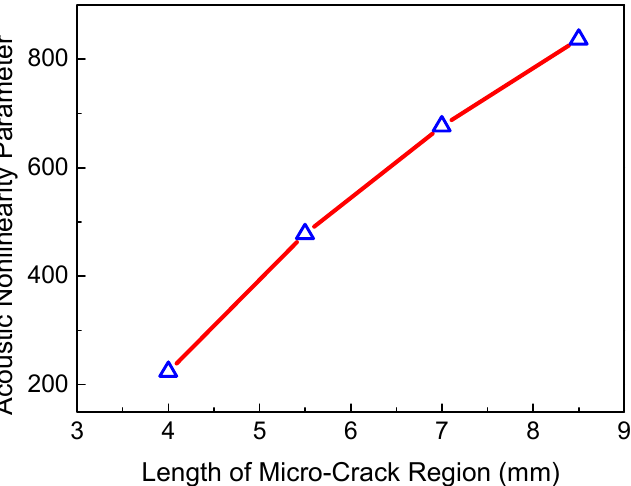
Figure 7. ANP versus the size of micro-cracks ( c = 0.009375, f R = 6 MHz, μ = 0, L 3 = 36 mm).